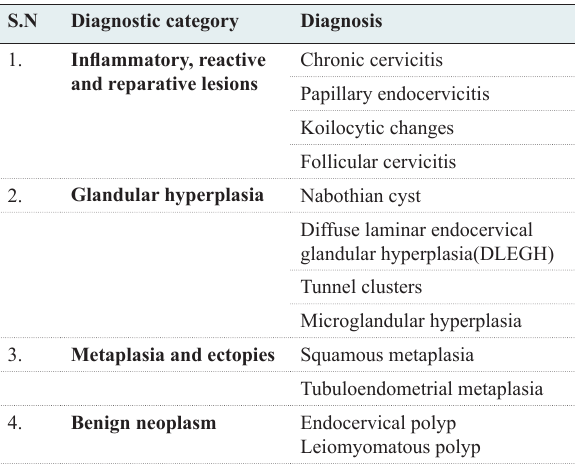
Table 1: Diagnostic category and various disease conditions